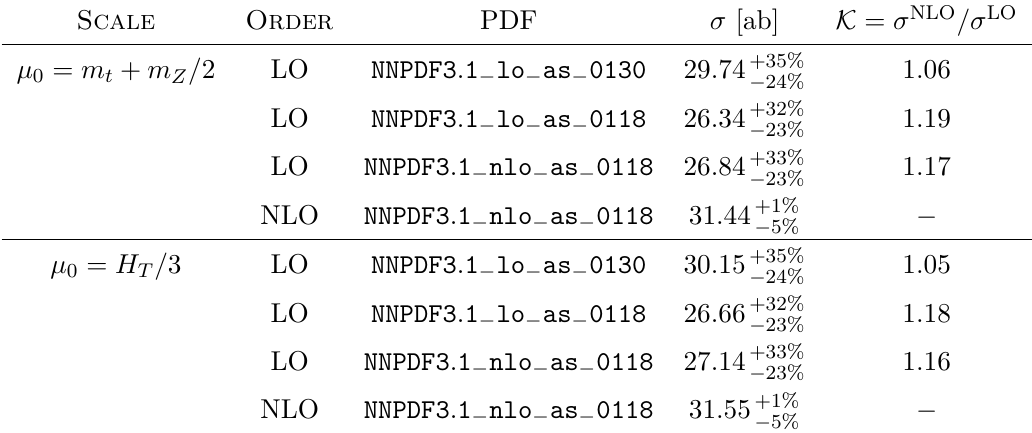
Table 6 . LO and NLO integrated fiducial cross sections for the pp → e + ν e µ − ¯ ν µ b ¯ b τ + τ − + X √ process at the LHC with s = 13 TeV. Results are evaluated for the more exclusive setup, which considers the cuts of eq. (4.4) on top of the standard kinematical cuts, using µ R = µ F = µ 0 where µ 0 = m t + m Z / 2 and µ 0 = H T / 3 . Three PDF sets are employed for LO predictions with different values of α s ( m Z ) . In the last column the K -factor, defined as σ NLO /σ LO , is shown. Monte Carlo errors are at the permille or sub-permille